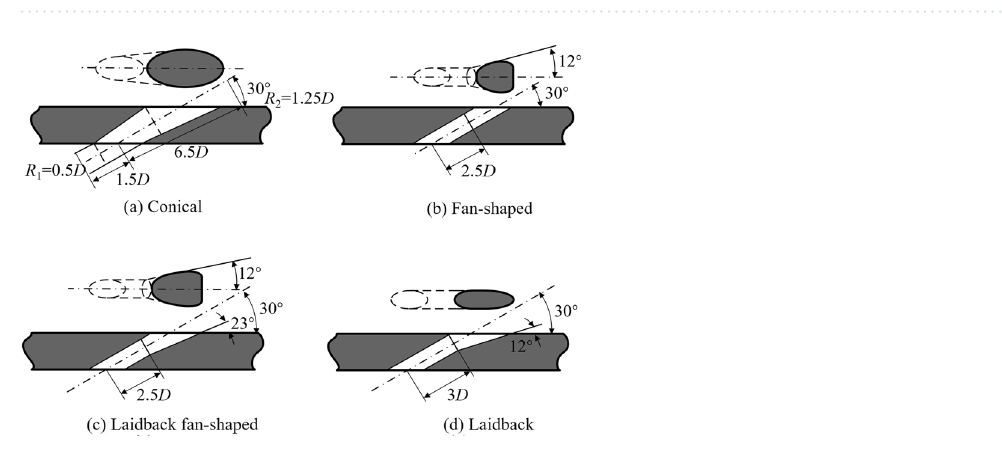
Figure 7. Typical shaped-hole in film cooling model.